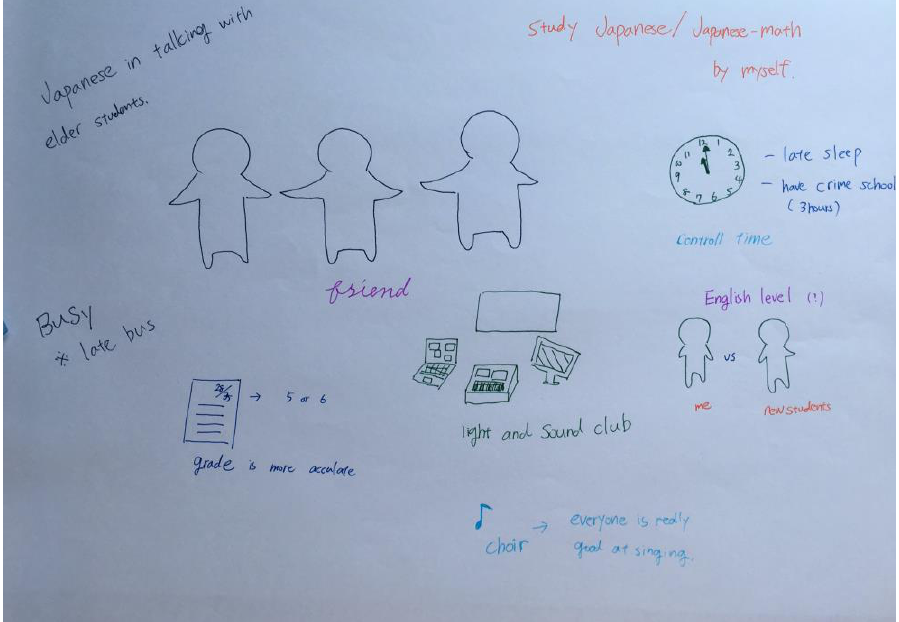
Figure 2. Balance between home life, schoolwork, and after-school activities was identified as one of the most stressful aspects of the middle school to high school transition. The impact of change reached to other levels of the school.